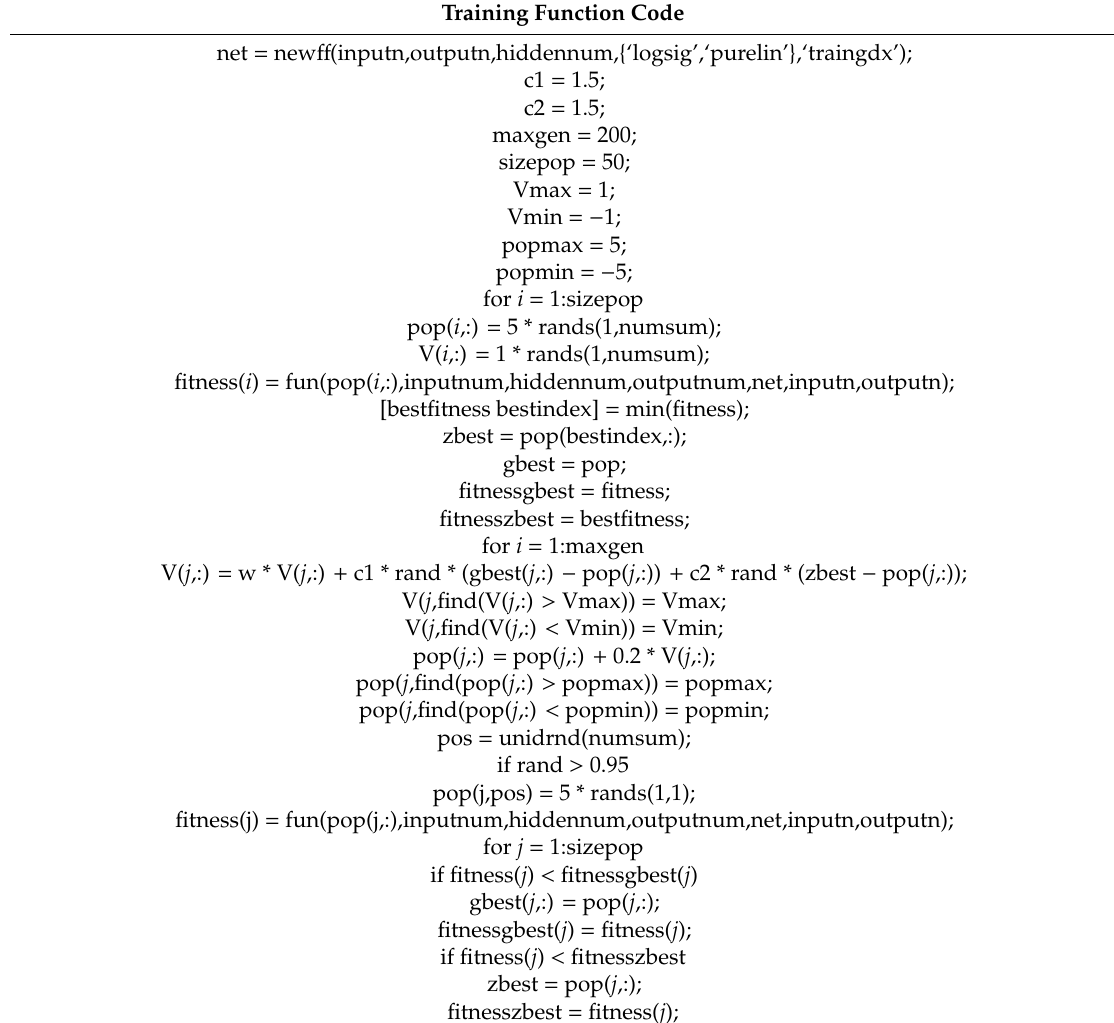
Table A2. Partly of PSO–BP–ANN training function